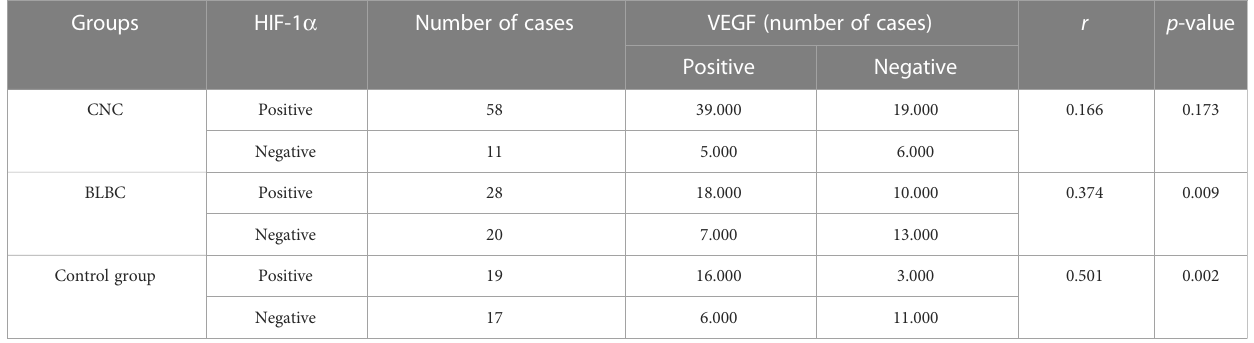
TABLE 7 Correlation analysis of HIF-1 a and VEGF in CNC and BLBC and CNC and control group. Groups